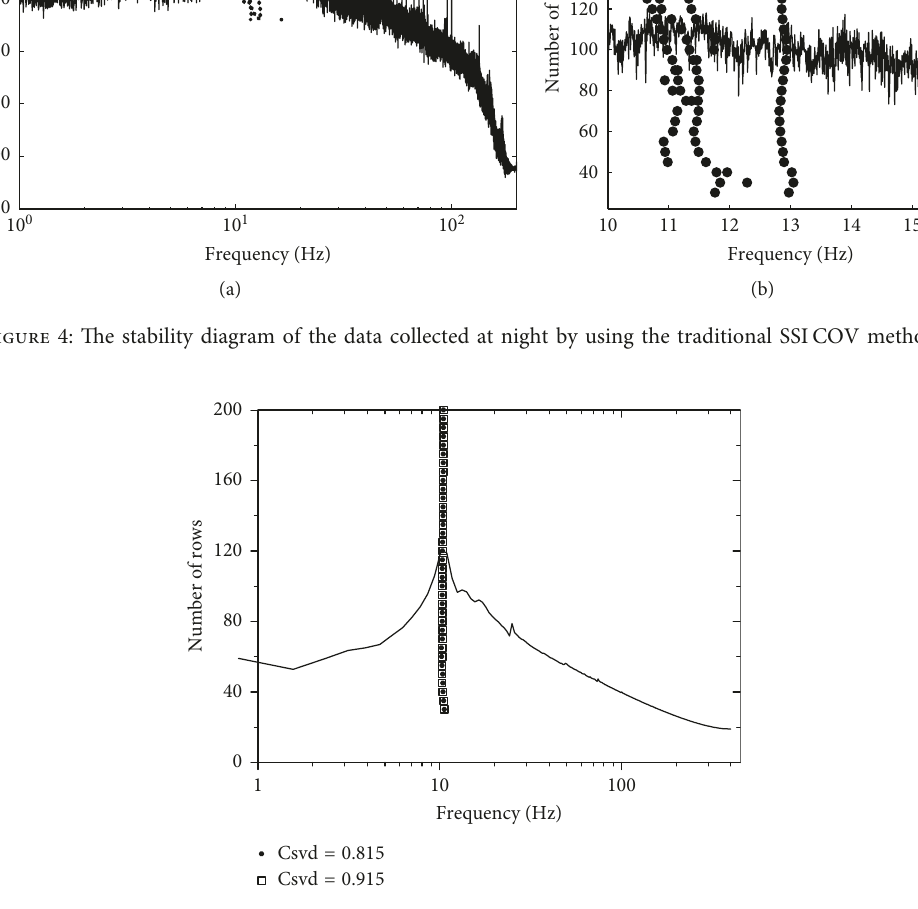
Figure 5: The stability diagram of the data collected at night by using the NExT-SSI-COV method. SSI-COV Csvd = 0.915 200